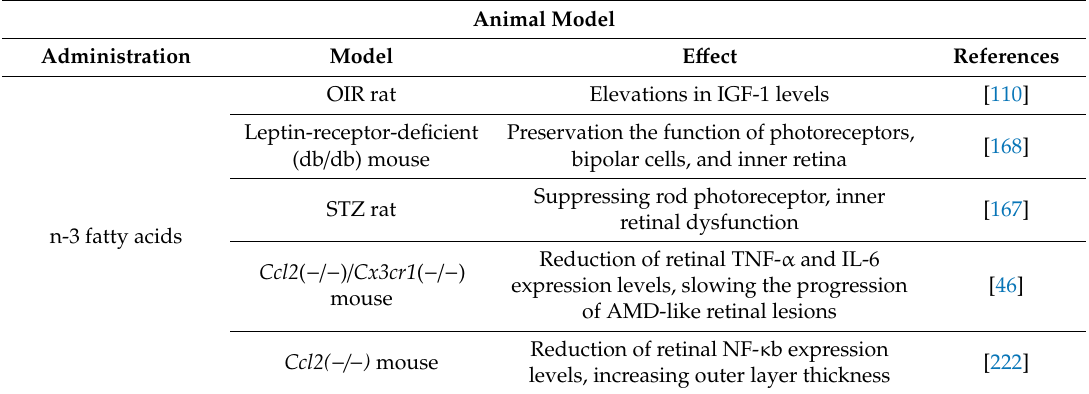
Table 1. The therapeutic e ff ects of the di ff erent n-3 fatty acids, the models in which they are tested, and the mechanisms